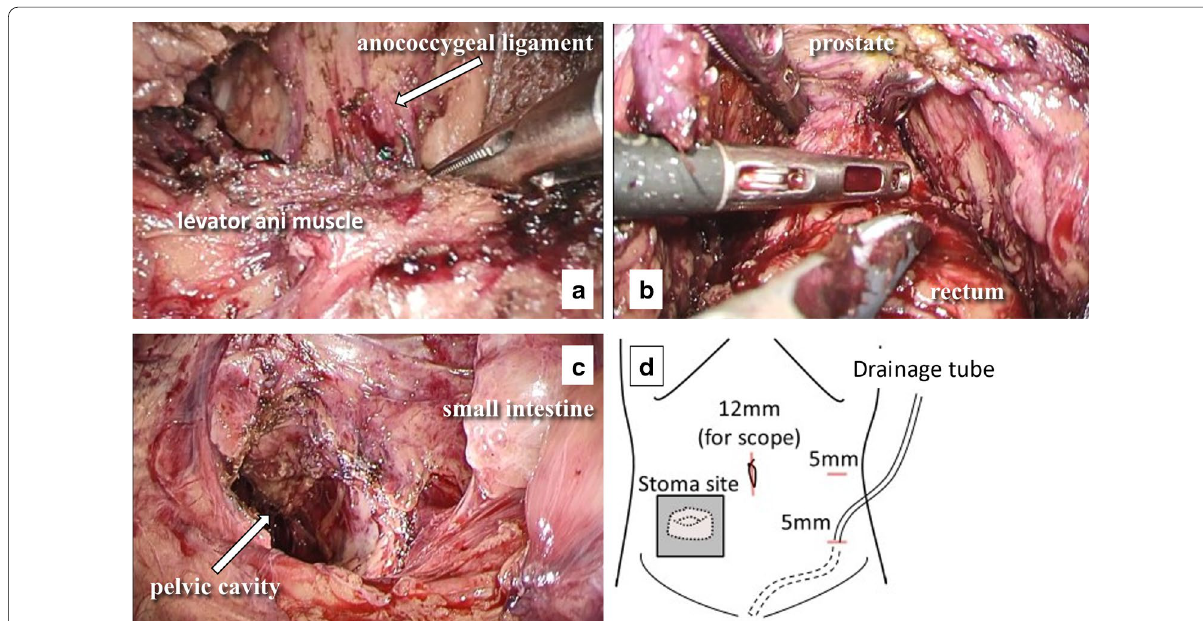
Fig. 2 Operative views. a Transanal view. After dissecting the levator ani muscle, the anococcygeal ligament was explored. b Transabdominal (laparoscopic) view. After rendezvous of the transanal and transabdominal space, the residual rectum was dissected from the dorsal side to lateral side. The prostate was explored laparoscopically, and the layer between the prostate and the residual rectum was dissected with support from the transanal approach to avoid injuring the rectourethral muscle and the urethra. c Transabdominal (laparoscopic) view after resection of the residual rectum. Strong adhesion of the small intestine to the pelvic wall was observed, and the natural pelvic anatomy was unclear because of the history of multiple surgeries. d Schema of the intraoperative overview of the abdomen. During the operation, the end ileostomy was covered by gauze and plastic film. A drainage tube was inserted from the left lower incision, through which a port was inserted, to the pelvic cavity after the